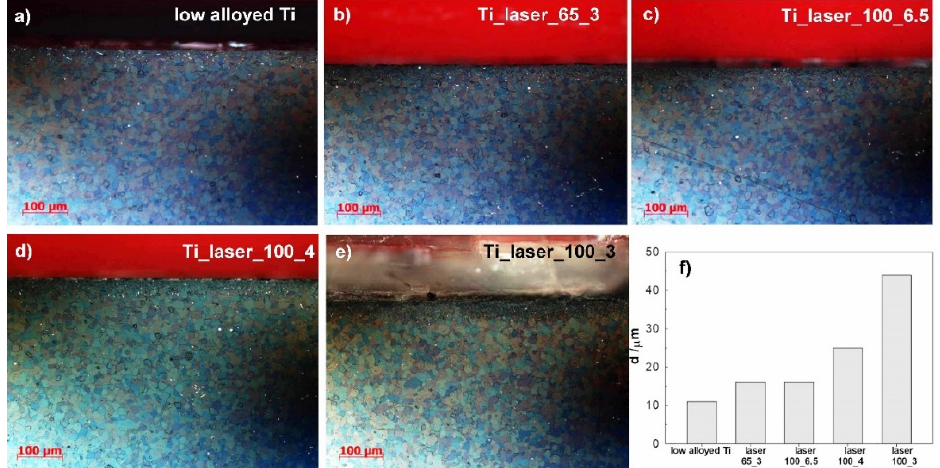
Figure 2. Microstructural investigation of laser marked surfaces in a cross-sectional view on low alloyed Ti foil ( a ), on a sample Ti_laser_65_3 ( b ), on a sample Ti_100_6.5 ( c ), on a sample Ti laser_100_4 ( d ), on a sample Ti_laser_100_3 and ( e ) the effect on the changed heat affected zone in cross section ( f ).